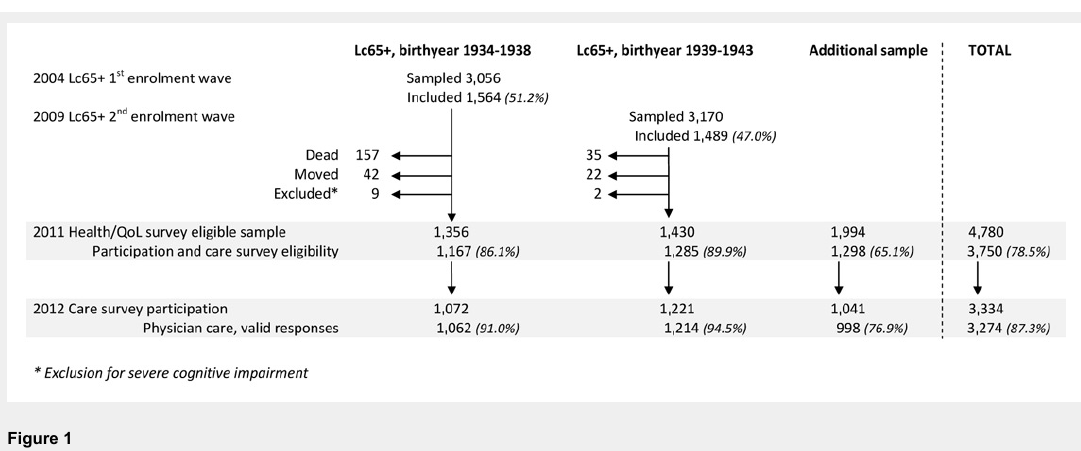
Figure 1 Care survey flow